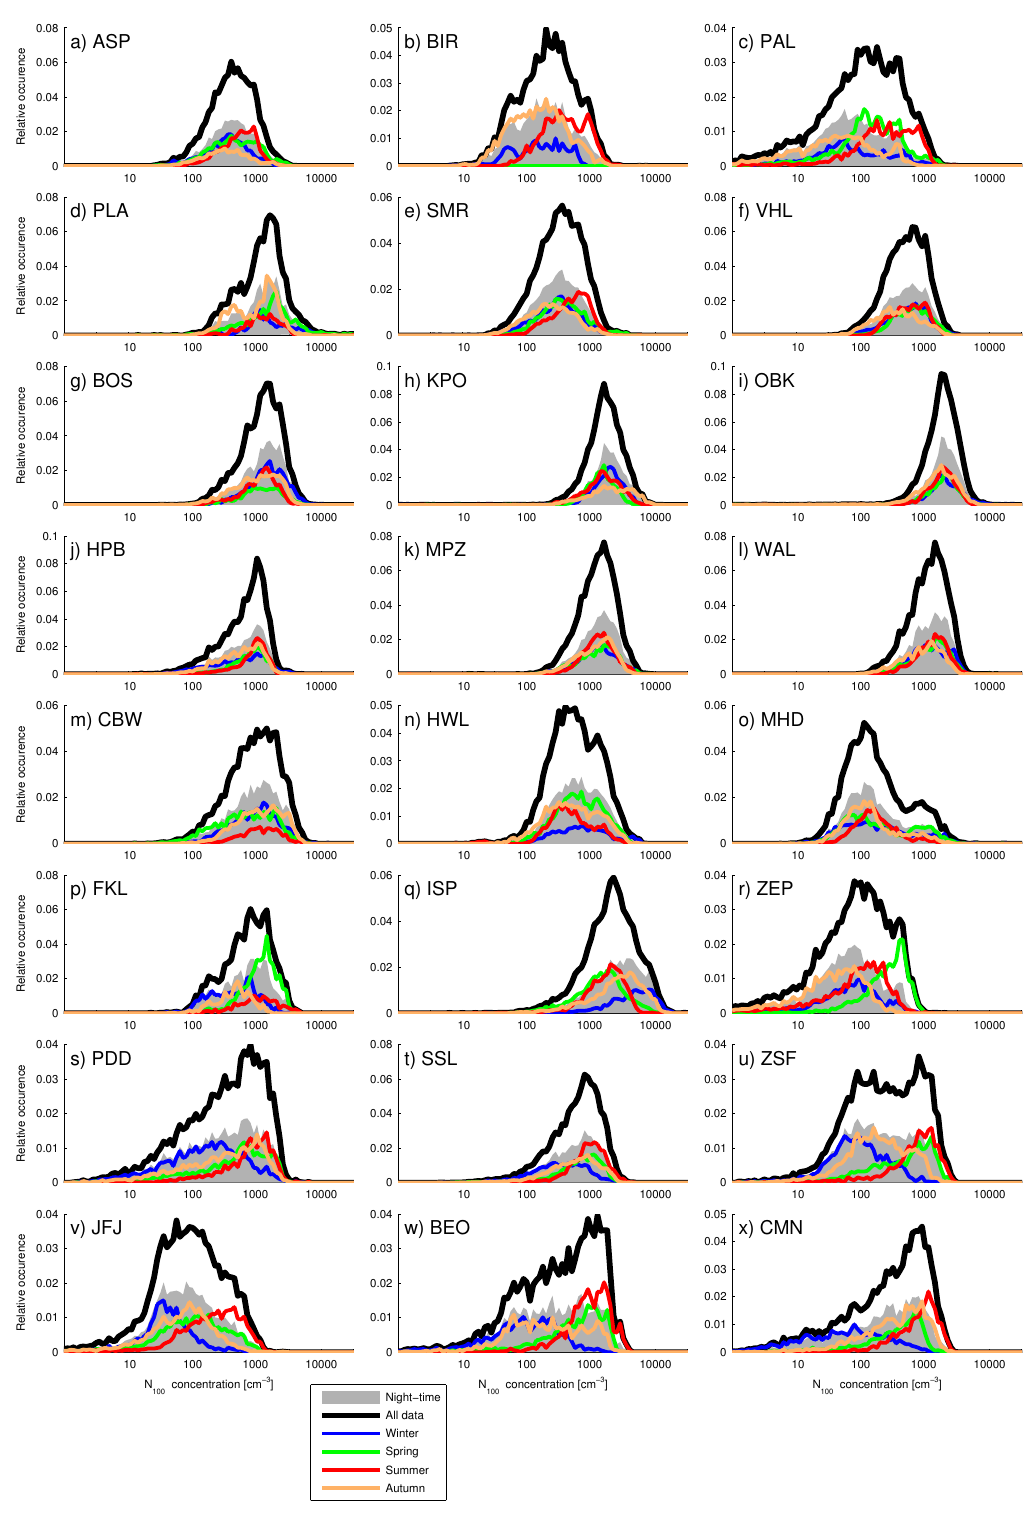
Fig. 11. Histograms of N 100 concentrations at the stations. See Fig. 9 for